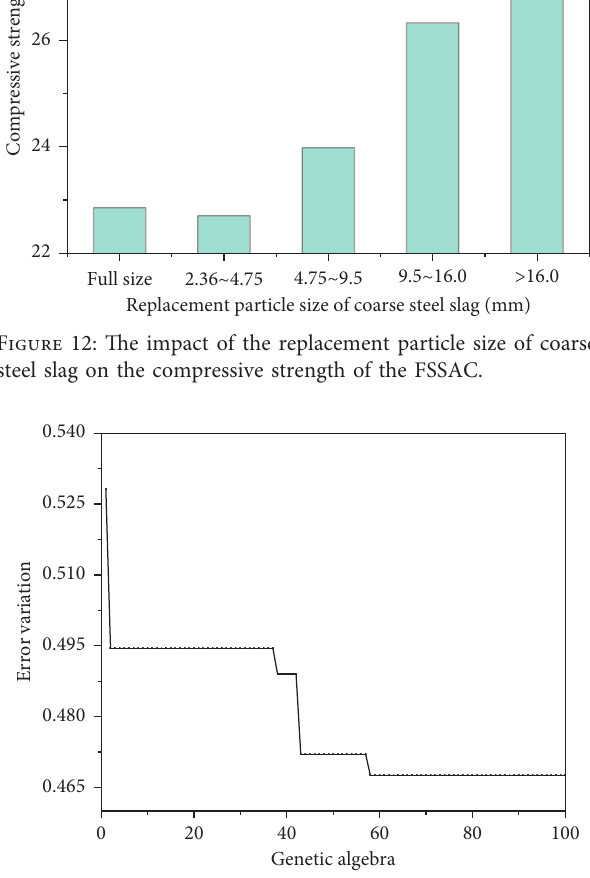
Figure 13: The genetic algebra and error variation of the expansion rate of the FSSAC.